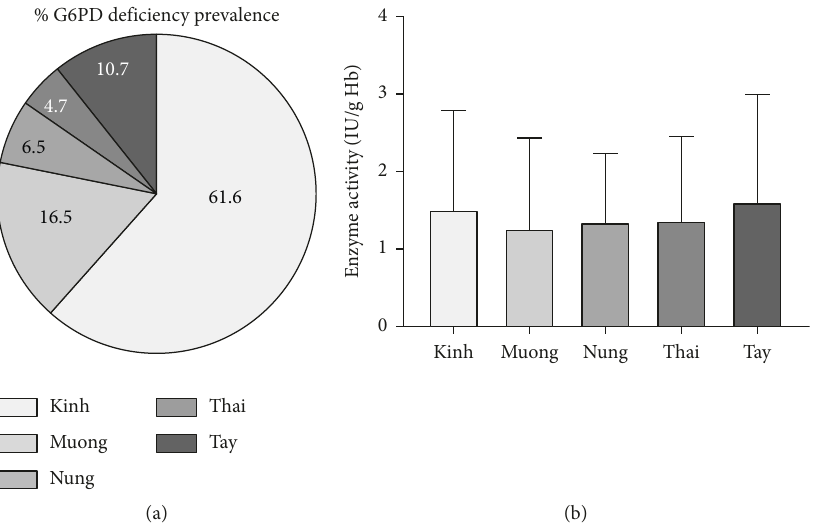
Figure 2: The prevalence and G6PD enzyme activity among Vietnamese ethnics. (a) The prevalence of G6PD deficiency among five different ethnicities. (b) Distribution of G6PD activities according to ethnic groups.